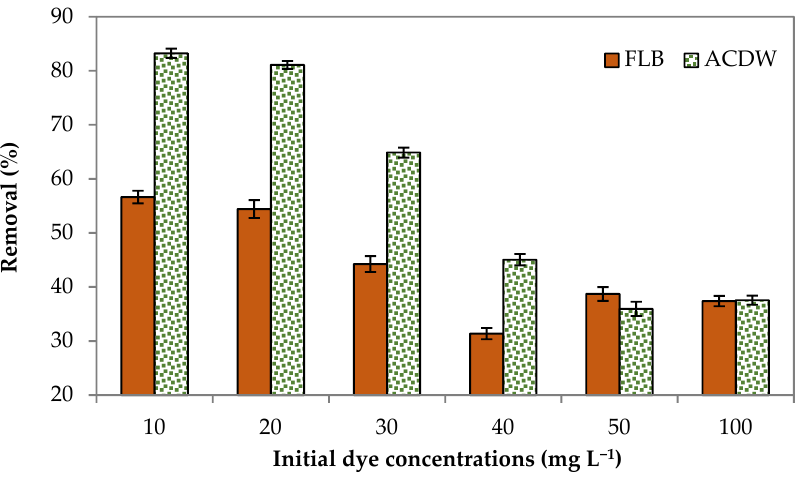
Figure 5. Influence of initial dye concentrations on elimination efficiency of IV2R dye.